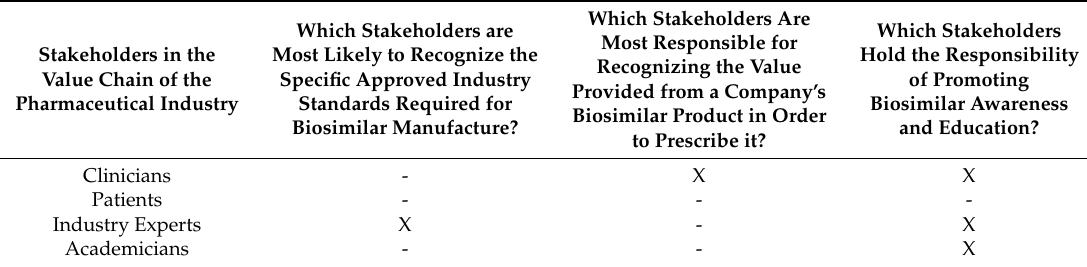
Table 1. Identification of stakeholders to be targeted for the